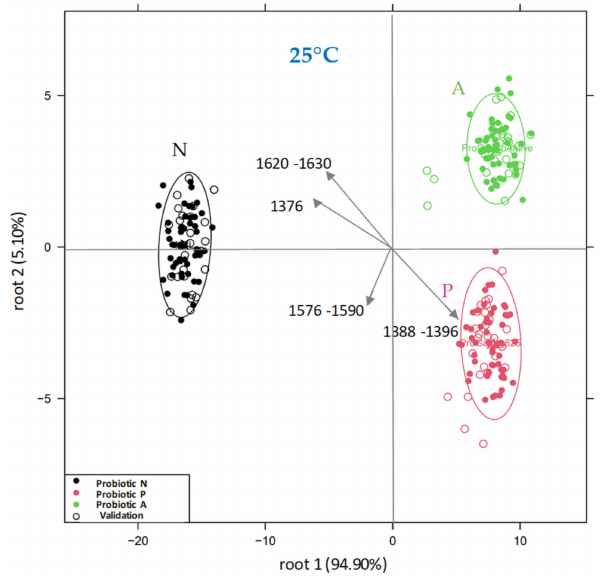
Figure 3. PCA-LDA of probiotic samples prepared at room temperature of 25 ◦ C. N = 237 (NIR samples scans). Built with 95% confidence interval ellipsis. The center of the ellipses is denoted by x, training and validation sets are denoted by solid and hollow points,